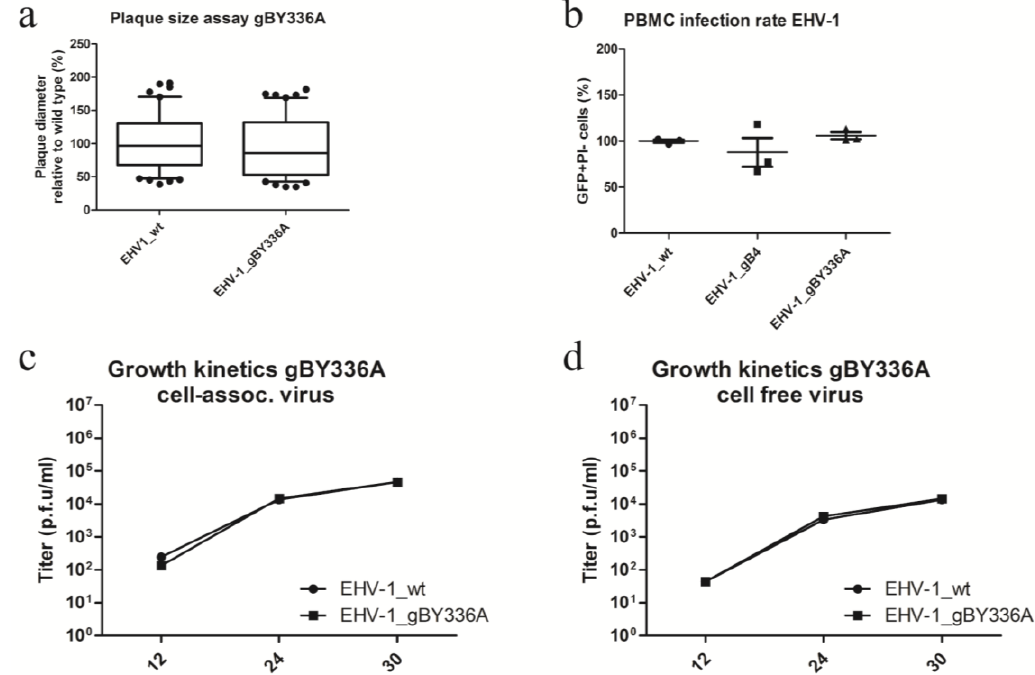
Figure 7. Characterization of EHV-1_gBY336A. ( a ) ED cells were infected with the respective viruses at an MOI of 0.01. Means ± SD of diameters of 100 plaques measured for each virus are shown. The plaque diameter of parental viruses was set to 100%. No significant differences (one-way ANOVA; p > 0.05) between parental EHV-1 and EHV-1_gBY336A were evident; ( b ) One million peripheral blood mononuclear cells (PBMC) were incubated with parental and recombinant EHV-1 viruses at an MOI of 1 for 24 h at 37 °C. After incubation, the percentage of infected cells was determined by flow cytometry. The rate of infection of parental virus was set to 100%. All data represent the means ± SD of three independent experiments (Kruskal–Wallis one-way analysis of variance; p > 0.05). For single-step growth kinetics of EHV-1 recombinant viruses, ED cells were infected at an MOI of 0.1 ( c,d ), followed by citrate treatment (pH = 3) to